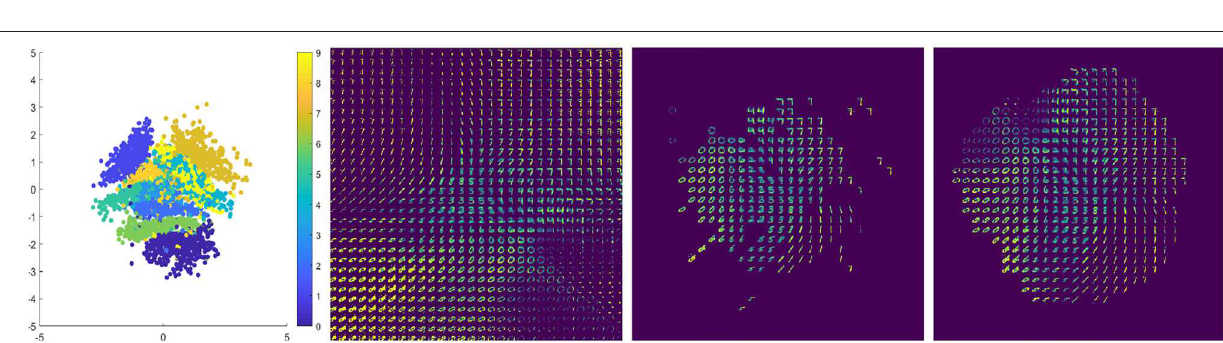
FIGURE 2 | Left to right: (1) Embedding of training data into 2D VAE latent space. (2) Reconstructed images from grid sampling in 2D VAE latent space. (3) Reconstructed images only of grid points that are deemed “significant” by the witness function with the localized kernel (4) Reconstructed images only of grid points that are deemed “significant” by the witness function with the Gaussian